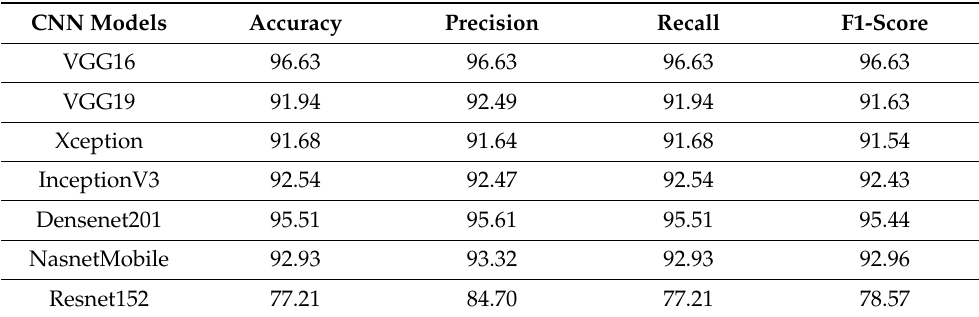
Table 6. Weighted average of performance metrics by different deep learning models for three-class classification into COVID-19, viral pneumonia, and normal.